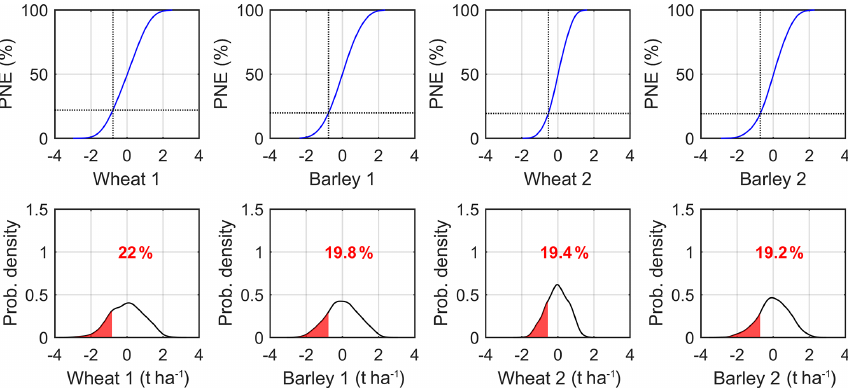
Figure 5. Probability of non-exceedance (PNE) function (%) of yield anomalies (top row) in both clusters based on the derived simulations from the estimated copulas and respective probability density estimates (bottom row). In the bottom row, the red values indicate the proba- bility of crop loss, which is also indicated in the top row by the intersected dashed lines, indicating the threshold of crop loss and respective PNE value.